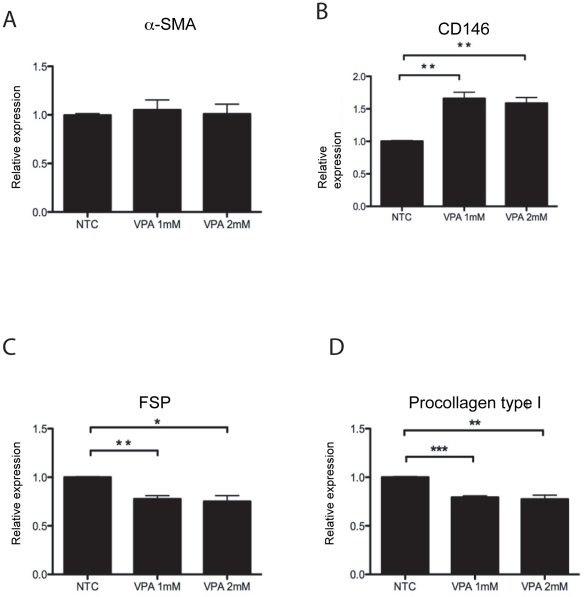
Effect of VPA on human pericyte differentiation.Quantification by flow cytometry, displayed as “relative expression” compared to NTC pericytes (1.0) within “sets” of 10.000 analyzed cells, of protein markers that define different stages of the differentiation process from microvascular pericyte to collagen type I producing fibroblast in pericyte cultures exposed to 1 mM and 2 mM VPA compared to NTC. (A) α-SMA, (B) CD146, (C) FSP, (D) procollagen type I. Mean ± SD, n = 3. T-test * p<0.05, ** p<0.01, *** p<0.001.